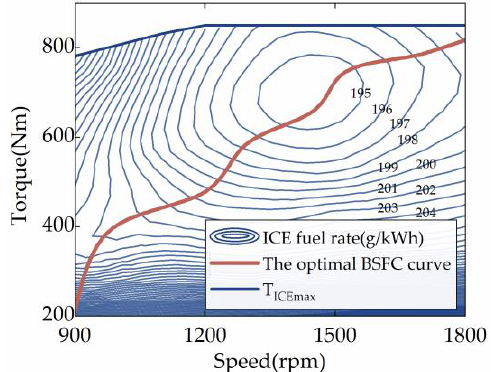
Figure 2. Optimal BSFC curve of the ICE.